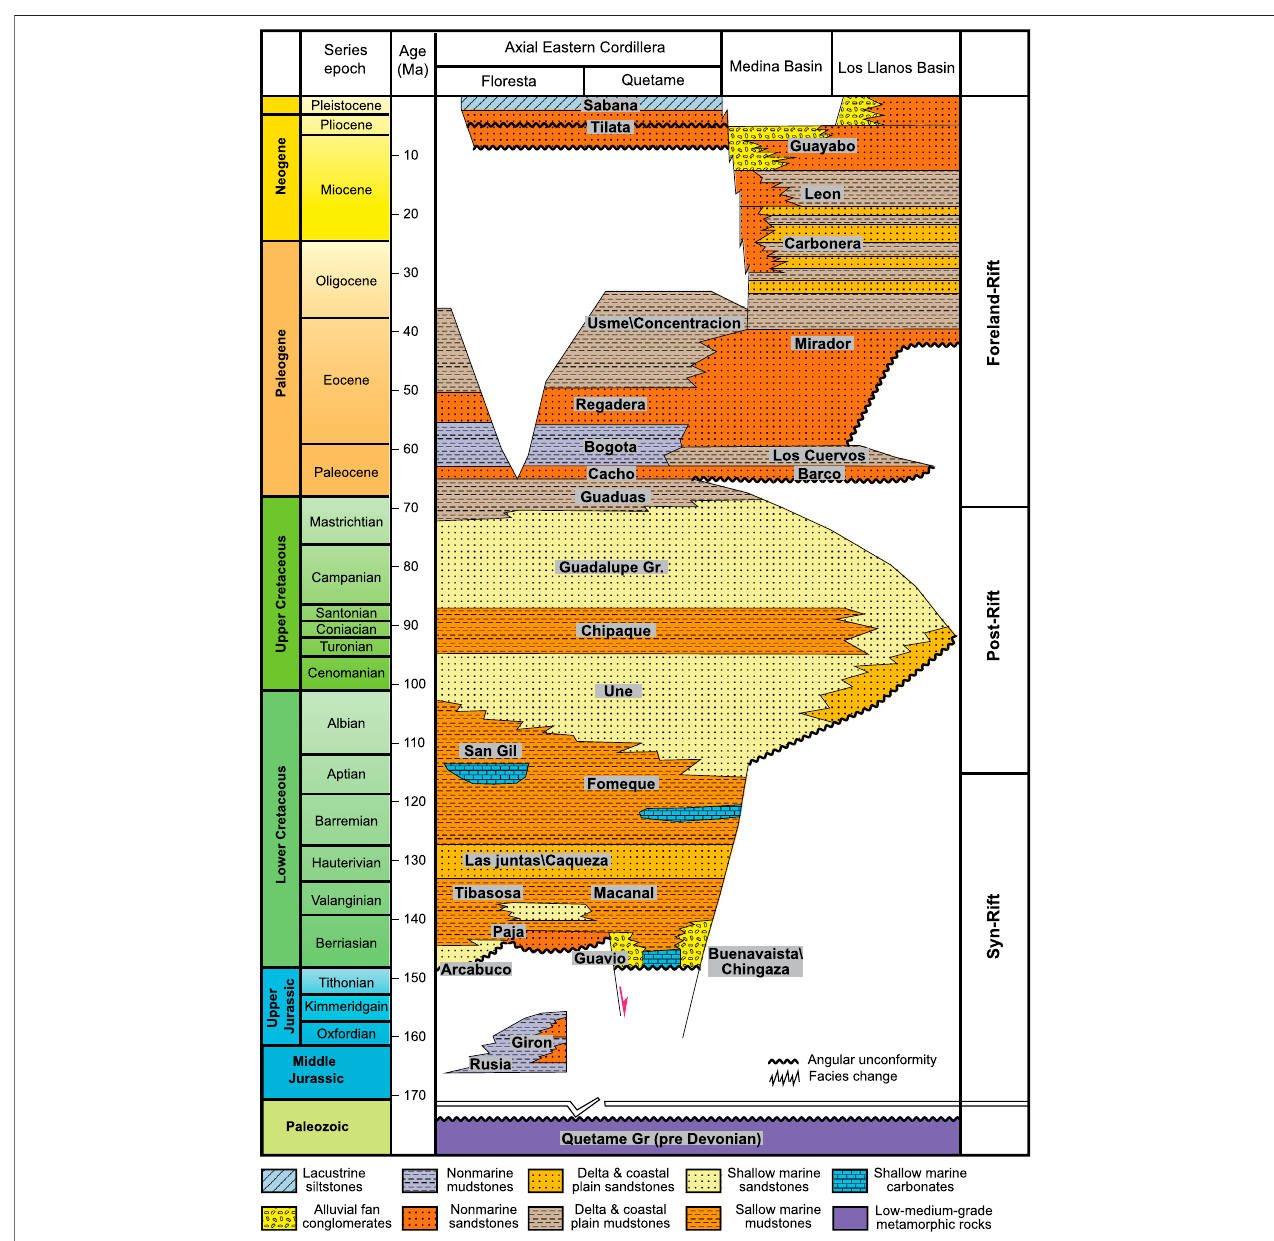
FIGURE 3 | Stratigraphic column of the Eastern part of Eastern Cordillera, Medina, and The Llanos basin (modi fi ed from Cooper et al., 1995; Parra et al., 2009a).